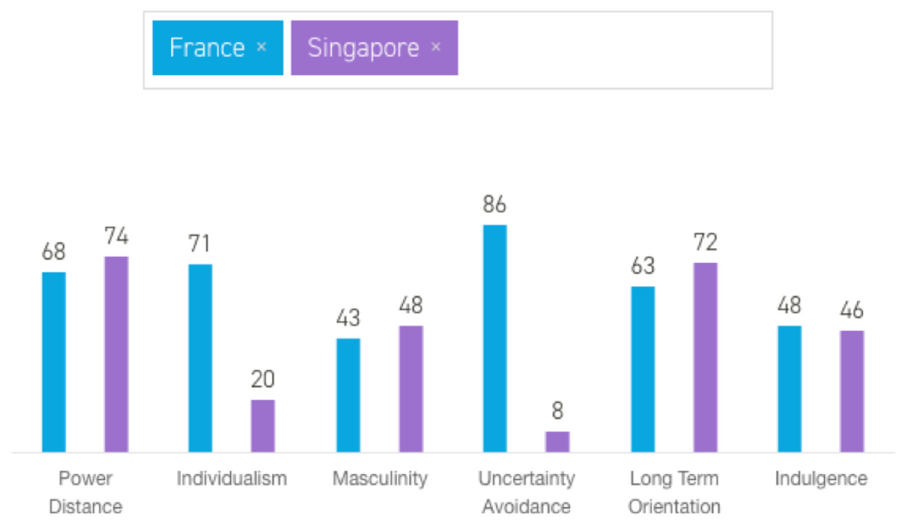
Figure 2. France and Singapore comparison according to the 6-Dimensions Hofstede